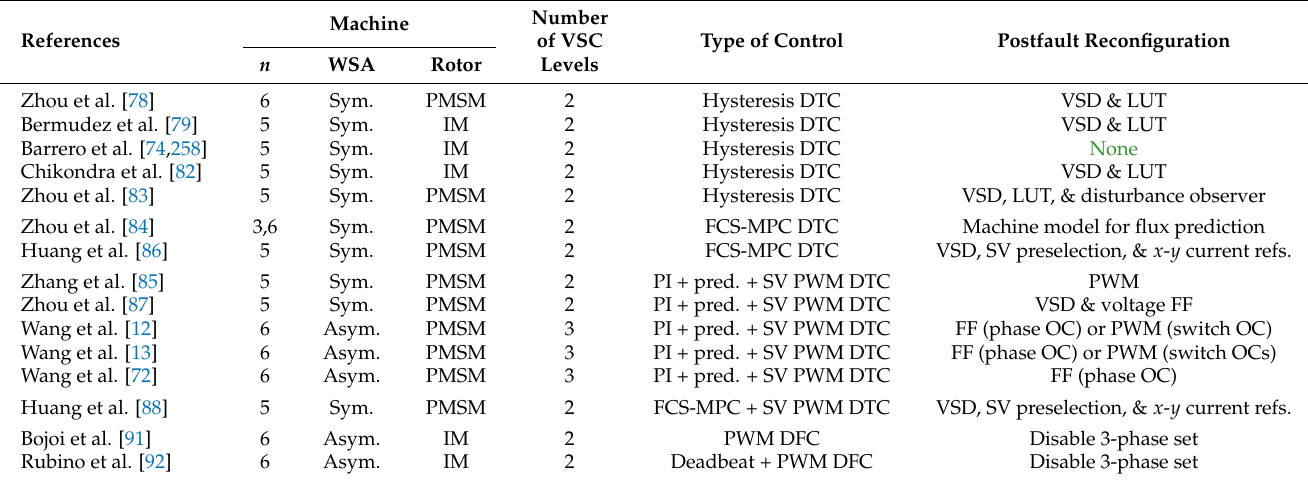
Table 6. Methods based on direct torque/flux control for tolerating phase OCs (Section 3.3) in multiphase applications in the